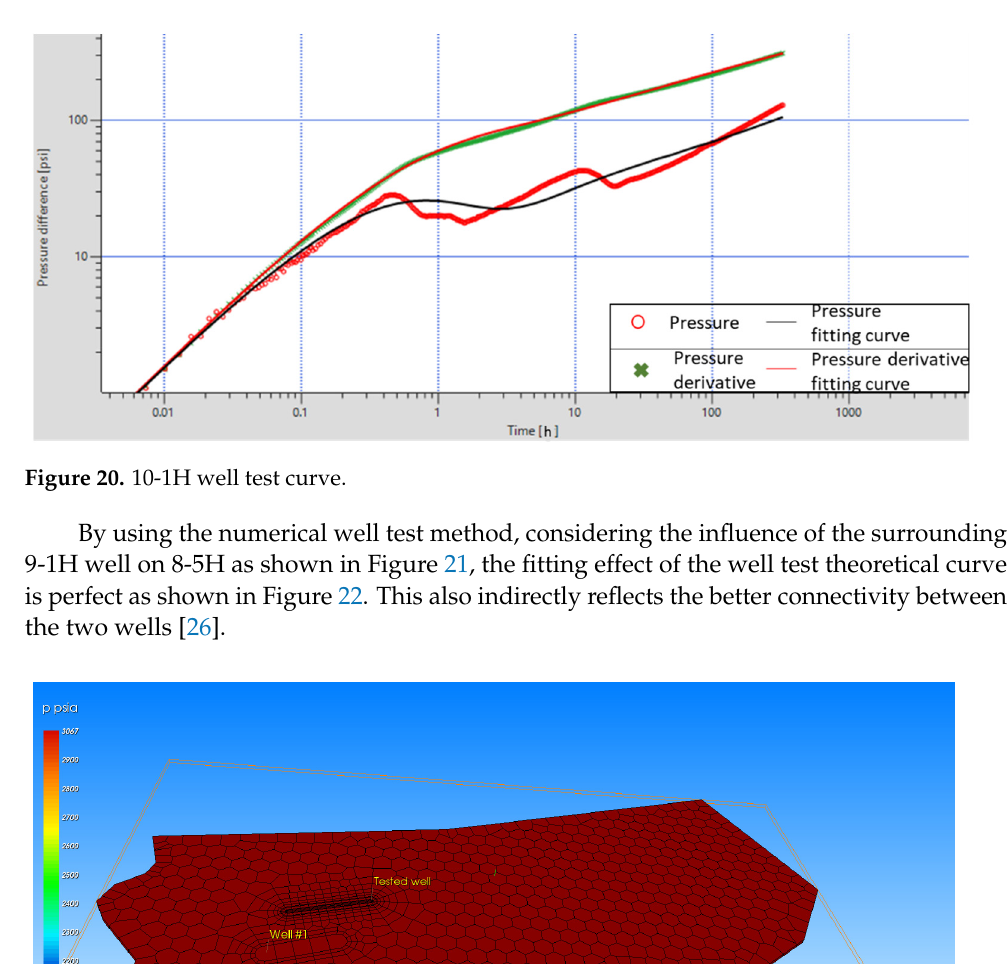
Figure 19. 8 ‐ 5H well test curve.